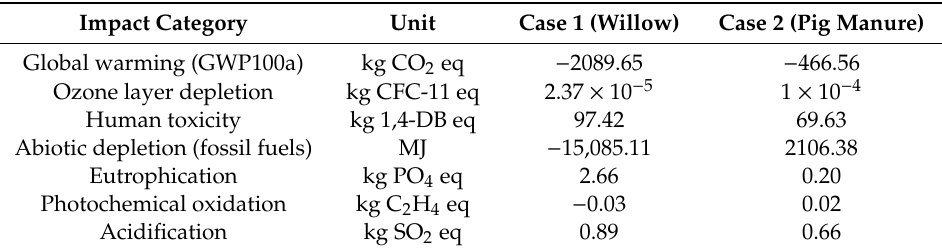
Table 6. CML characterization results (per ton of